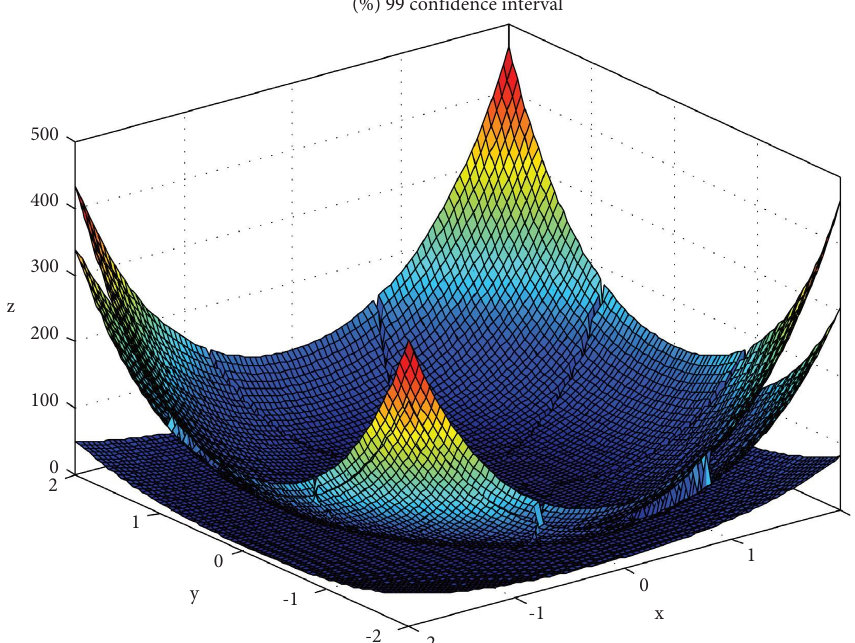
Figure 6: Te 99% confdence interval of equation (29) for α � 1 , β �